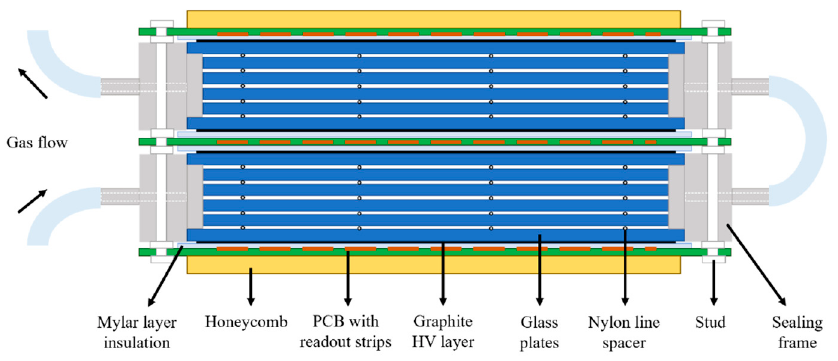
Figure 16. The cross-section view of the sealed MRPC. Reproduced with permission from Wang et al., Journal of Instrumentation; published by IOP Publishing for Sissa Medialab, 2020 [100].